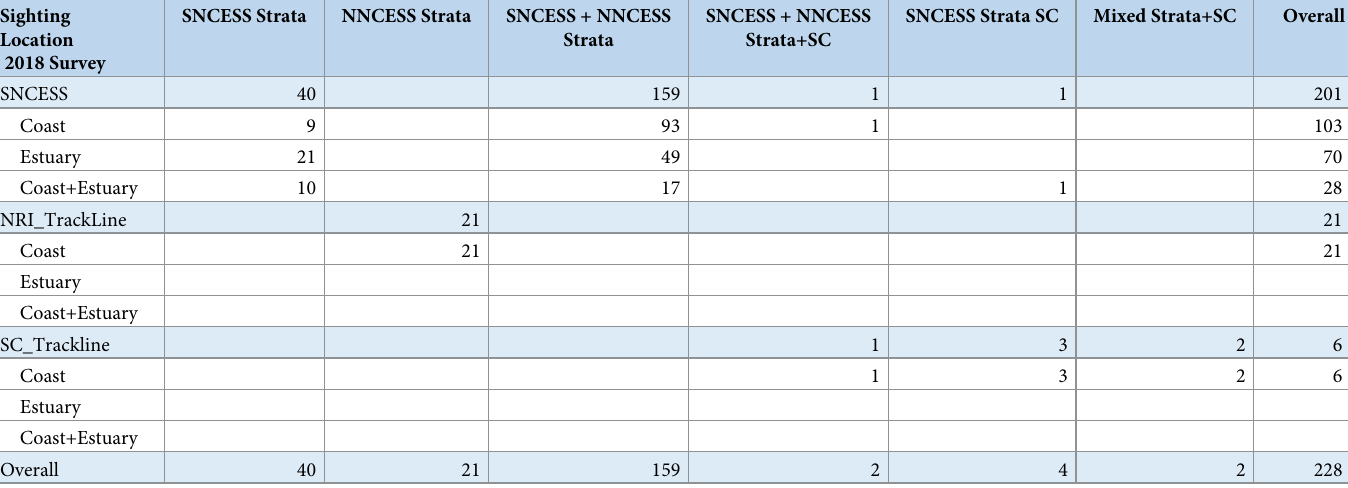
Table 4. Stock-strata assignments for estuarine-resident common bottlenose dolphins ( Tursiops truncatus ) from sighting